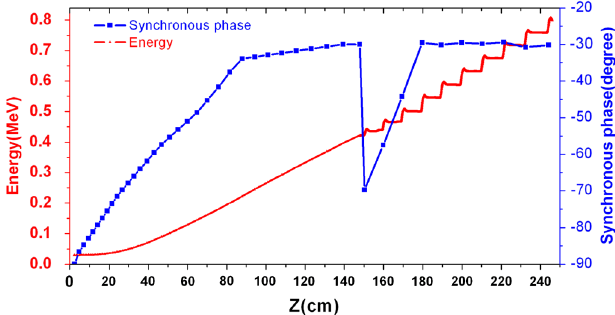
FIG. 11. Synchronous phase-cell number curve of coupled RFQ-SFRFQ cavity (subtracts 180 (cid:2) at the end of each cell).